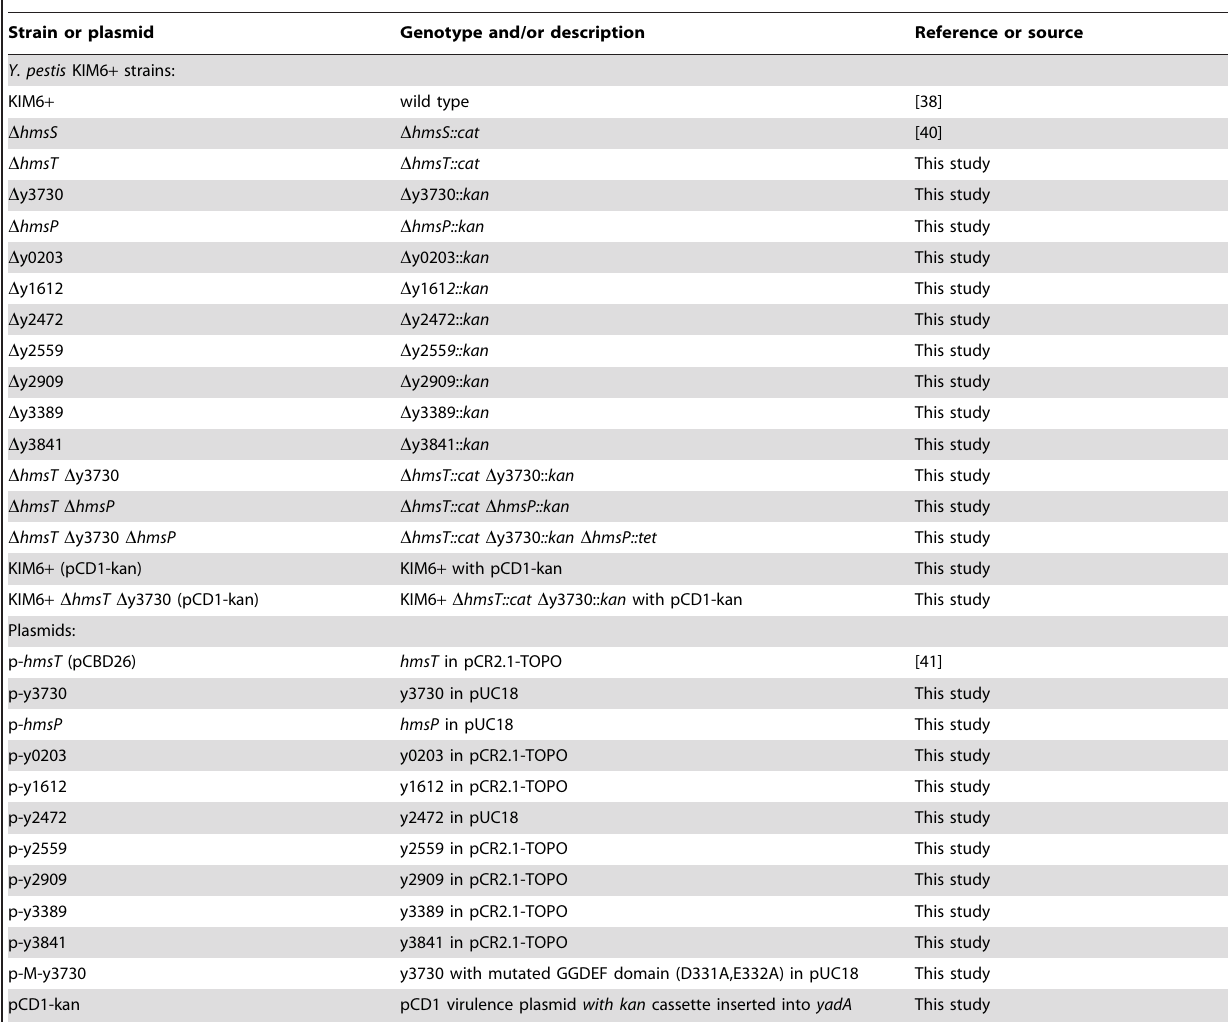
Table 3. Strains and plasmids used in this